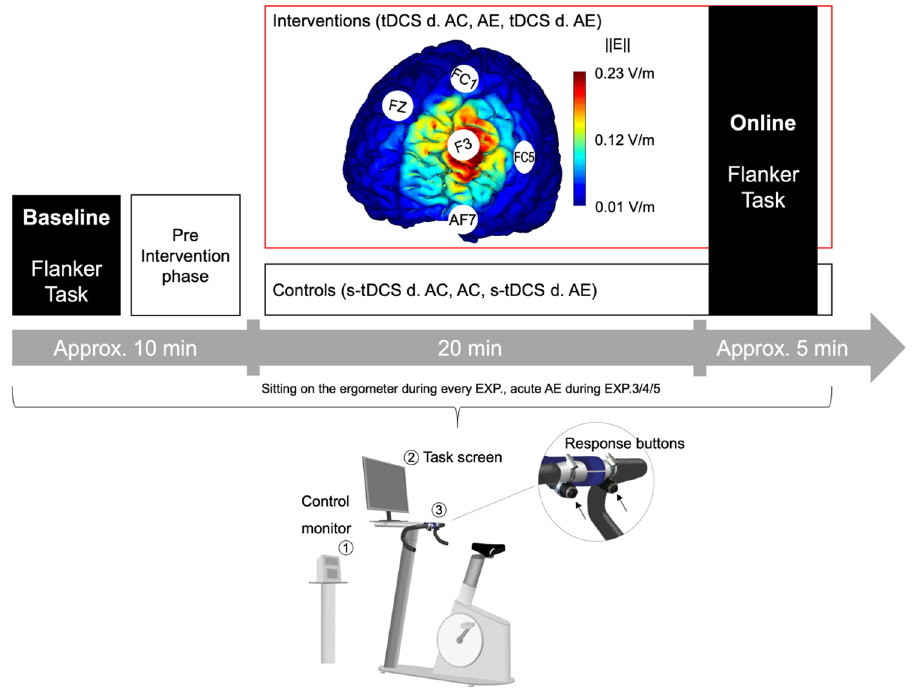
Figure 3. Experimental design and timeline, tDCS montage, and cycle ergometer with cognitive test set-up. The upper part shows the computational model of the electric field (||E||) acting on the left DLPFC of the participants during anodal and cathodal tDCS (Neuroelectrics Instrument Controller version 2.0.10, Neuroelectrics, Barcelona, Spain). The middle part shows the experimental timeline comprising the intervention (EXP. 1: a-tDCS alone, EXP. 2: c-tDCS alone, EXP. 3: AE alone, EXP. 4: a-tDCS during (d) AE and EXP. 5: c-tDCS during AE) and control conditions (EXP 1.: s-tDCS alone, EXP. 2: s-tDCS alone, EXP. 3: Active control (AC), EXP. 4: s-tDCS during AE and EXP. 5: s-tDCS during AE). Active control (AC) was applied in all control conditions, which means that even during s-tDCS, all participants sat on the cycle ergometer and cycled with a very low intensity of 15 Watts. The lower part shows the cycle ergometer with 1) the control monitor displaying to the investigator the heart rate, pedal cadence, and Watt; 2) the task screen where the cognitive tests were presented during cycling; and 3) the response buttons (The Black Box Toolkit) fixed at the steering of the ergometer, enabling participants to easily make responses by button presses without changing posture. Cycle ergometer drawing was done using the software